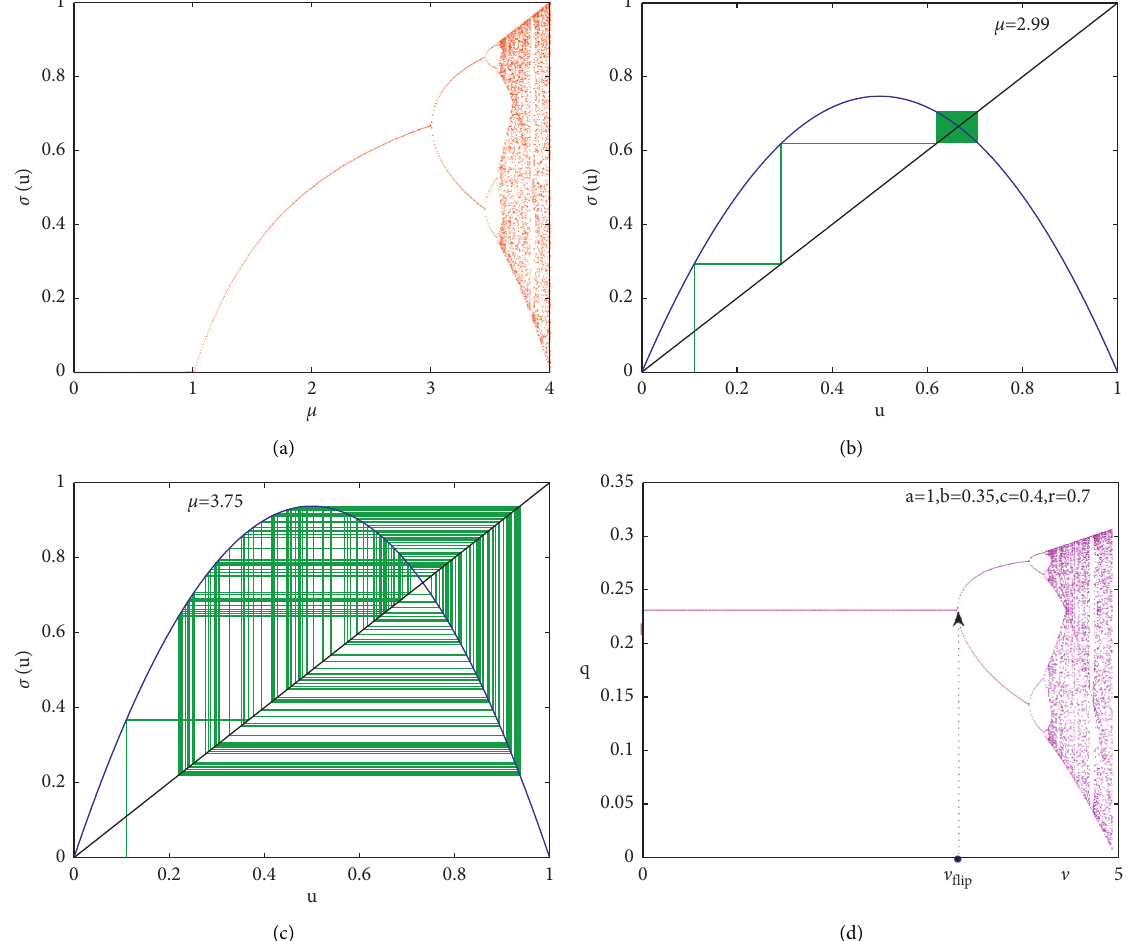
Figure 2: (a) 1D bifurcation diagram of map σ ( u ) with respect to μ 1. Iterations of σ ( μ ) at (b) μ � 2.99 and (c) μ � 3.75. (d) 1D bifurcation diagram for the map (14) at a � 1, b � 0.35, c � 0.4, and r �